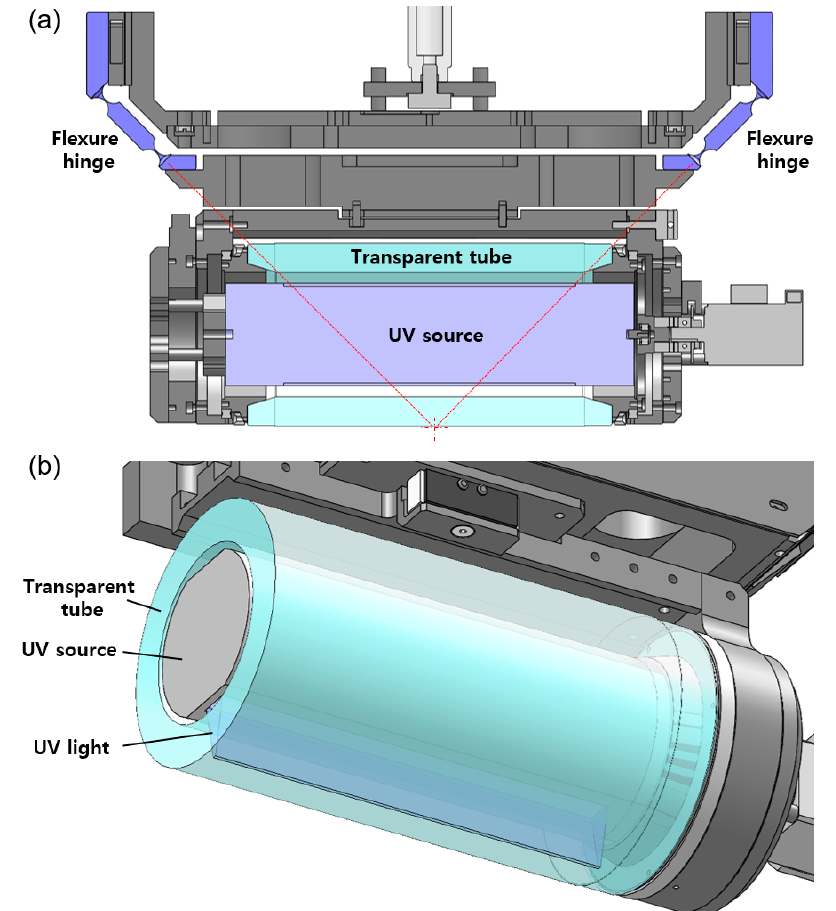
Figure 4. Cross section images of the stamp roll unit. ( a ) The passive angle compensation mechanism using flexure hinges; ( b ) the UV source installed inside the stamp roll (transparent tube).